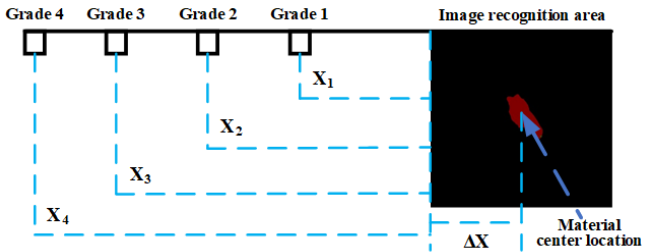
Figure 12. Schematic diagram of delayed positioning of material